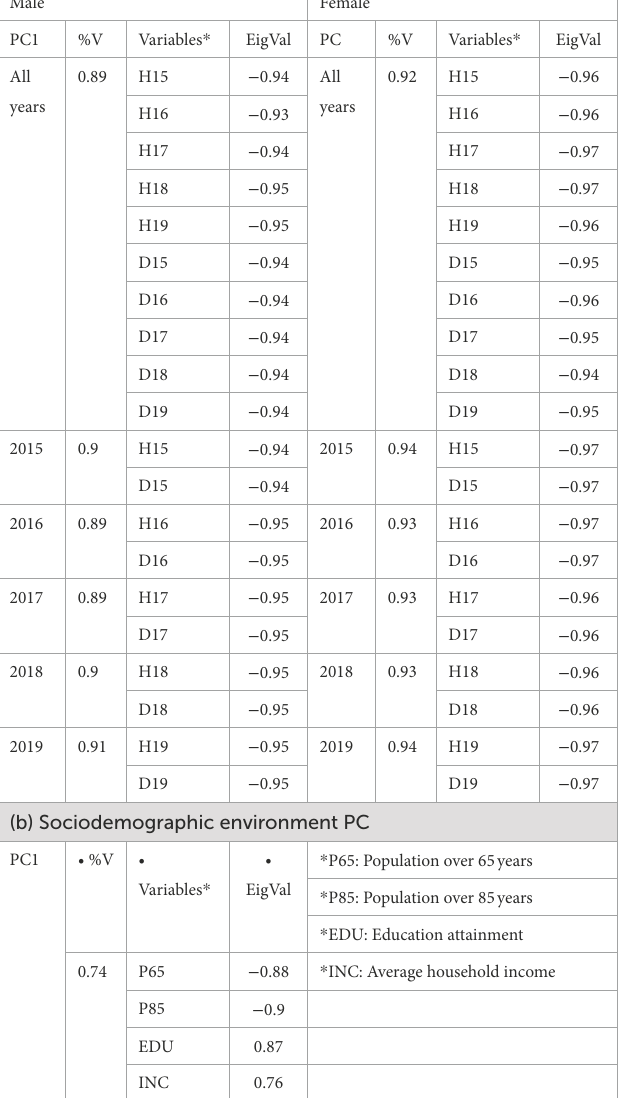
EigVal denotes the correlation value between the original variables and the PCs. * H, hypertension; D, diabetes. %V indicates the proportion of variance within the block gathered by the